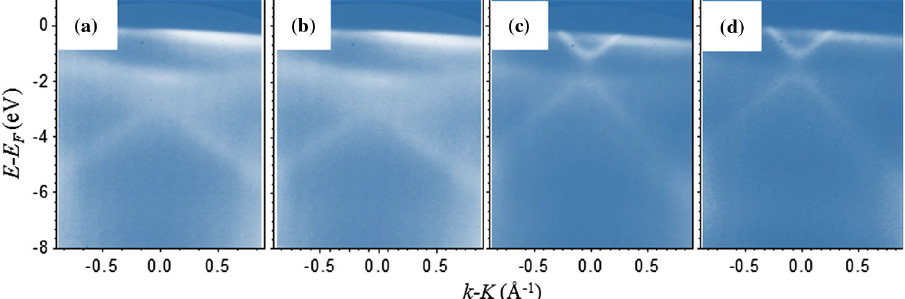
FIG. 7. Temperature-dependent ARPES data of the graphene measured at the K point (a) at − 140 °C, (b) after Na deposition at − 140 °C, (c) with the temperature increased to − 100 °C after the Na deposition, and (d) with the temperature increased to þ 20 °C after the Na deposition.